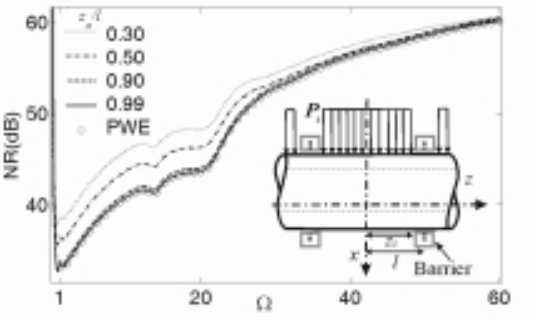
Fig. 16. Noise reduction of infinite cylinder with l/b = 1 under uniform wave excitation with different z 0 /l , PWE demonstrates plane wave